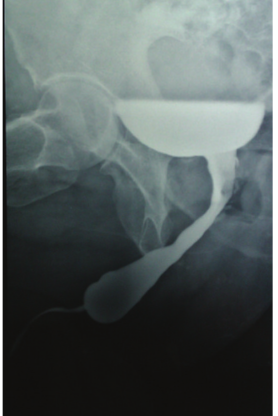
Figure 3: Stricture of the distal anterior